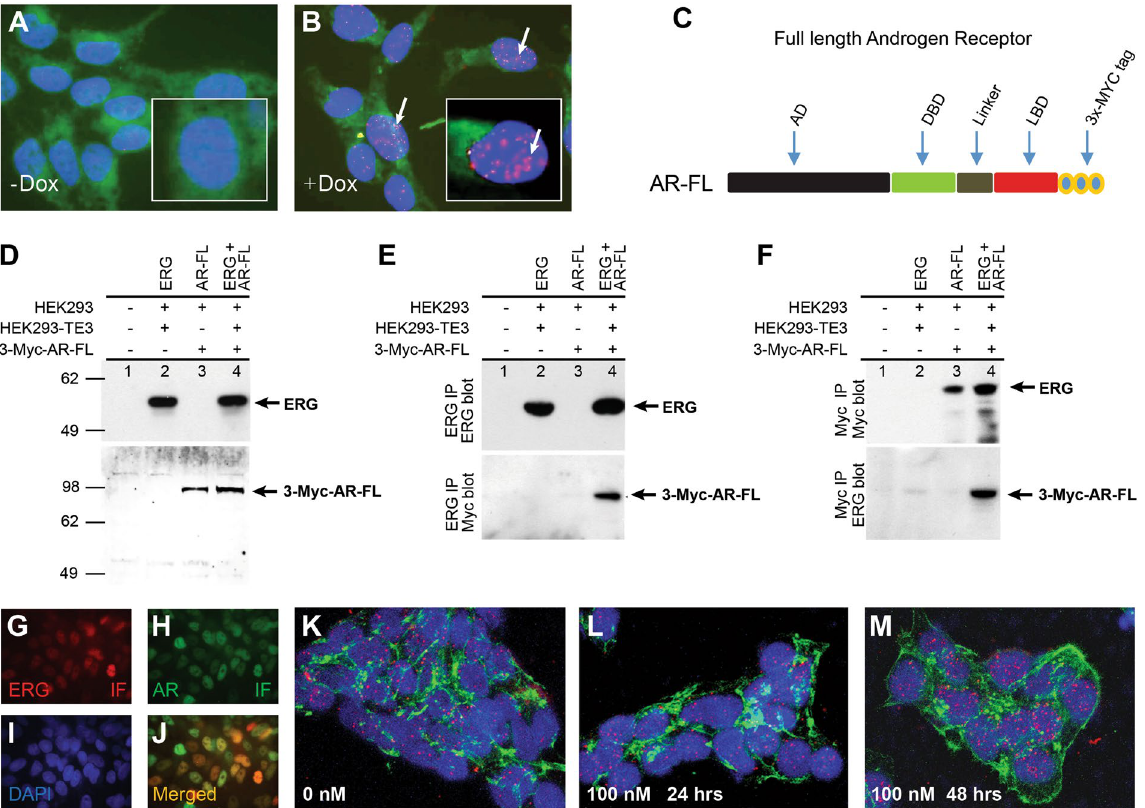
Figure 7. ERG physically interacts with Androgen Receptor. Proximity ligation assay (PLA) on LNCaP- LnTE3 cells without ( A ) or with ( B ) induction of ERG shows a positive interaction with AR protein. Graphical representation of 3x-MYC tagged AR full length and AR deletion construct ( C ) used to transfect HEK293 and HEK293-TE3 cells. HEK-293 and ERG expressing HEK 293-LTE3 cells grown in serum-starved conditions for 20 hours were transfected with full length AR and ERG constructs and stimulated with 1 nM R1881 for another 24 hrs. Immunoblot of cell lysates used in co-IP experiment were tested with anti-ERG MAb and anti-MYC-tag antibody as controls ( D ). ERG interactions with AR were detected by immunoprecipitation of ERG followed by westernblot with anti-ERG MAb (9FY) with mouse polyclonal IgG as control and immunoblotted with rabbit polyclonal anti-MYC-tag antibody ( E ). As a second approach, AR was immunoprecipitated with anti-MYC-tag antibody with rabbit polyclonal IgG as controll and immunoblotted with anti-ERG MAb (9FY) antibody ( F ). To further analyze if the interactions of ERG with AR are dependent on AR dimers or monomers, VCaP cells were grown on cover glasses in the presence of 100 mM resverotrol for 48 hours and PLA was performed to detect changes in physical interactions. Immunoflurescence analysis of ERG and AR in VCaP cells grown for 48 hrs showed colocalization ( G–J ). ERG-AR interactions by PLA showed the presence of interactions at 48 hrs resveratrol treated VCaP cells ( K–M